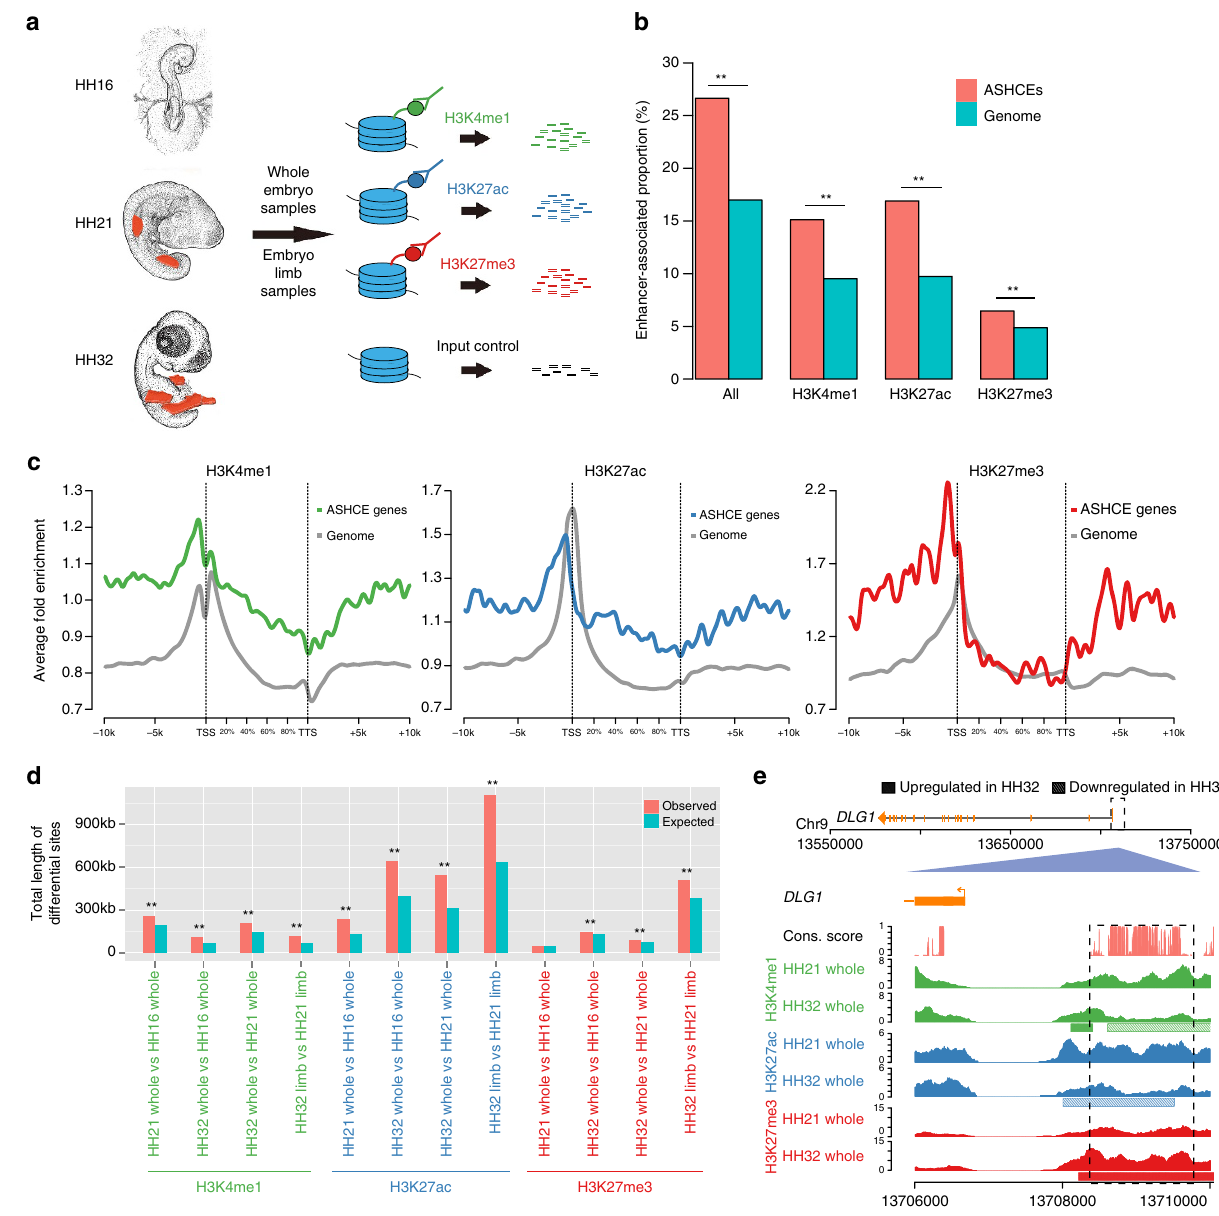
Figure 2 | Enriched histone marks in ASHCEs. ( a ) Schematic representation of ChIP-seq experiments. Whole embryo samples from HH16/HH21/HH32 stages and limb samples (red parts on embryos) from HH21/HH32 stages were collected for generating ChIP-seq data of three enhancer-associated histone modification marks (H3K4me1, H3K27ac and H3K27me3). ( b ) Over-representation of enhancer histone marks in ASHCEs. ** P o 0.001 (calculated by GAT). ‘All three marks’ means using the non-redundant union set of three types of peaks. ( c ) Average occupancy patterns of histone marks along the genic and 10kb flanking regions of ASHCE-associated genes and whole-genome genes. The fold enrichment values are normalized density relative to the input samples. The gene body length is aligned by percentage from the transcription start site (TSS) to transcription termination site (TTS). The upstream regions of genes show elevated occupancy relative to gene body and downstream regions. H3K4me1 and H3K27ac of ASHCEs show over-representation relative to genome background in gene body as well as in up- and downstream 10kb regions, except that the region very near TSS has weak or no over-representation. H3K27me3 also shows over-representation in up- and downstream regions, but not in the gene body. ( d ) Over-representation of differential histone marks in ASHCEs. The differential histone modification sites by comparing two samples at different developmental stages using diffReps. ** P o 0.001, 0.001 o *P o 0.05 (calculated by GAT). ‘Expected’ means the expected total length of differential sites if we randomly choose the same amount of loci as ASHCEs from whole genome. ( e ) A case of differential histone modification marks in the upstream of DLG1 . Normalized fold enrichment signals (normalized with input samples) of three histone marks at HH21 and HH32 stages are shown. The differential regions between HH21 and HH32 predicted by diffReps are also shown (bars under HH32 within 10 kb upstream/downstream of the transcription start or from the whole genome (Fig. 2c, Supplementary Table 17, termination sites, contain a significantly higher level of P value o 0.05, calculated by GAT). This suggests regulation of overlapping rate with histone modificated regions in these these genes may have become more rigorously controlled and embryonic stages compared with the average level of all genes maintained during the development.